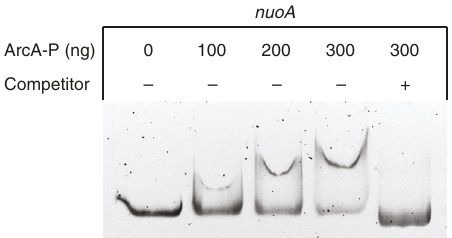
Fig. 7 EMSA using ArcA protein and the upstream region of nuoA . The labeled probe containing the upstream region of nuoA was incubated with 0 – 300 ng phosphorylated ArcA (ArcA-P) in the presence ( + ) or absence ( − ) of a speci fi c competitor (a 50-fold excess of unlabeled nuoA probe)